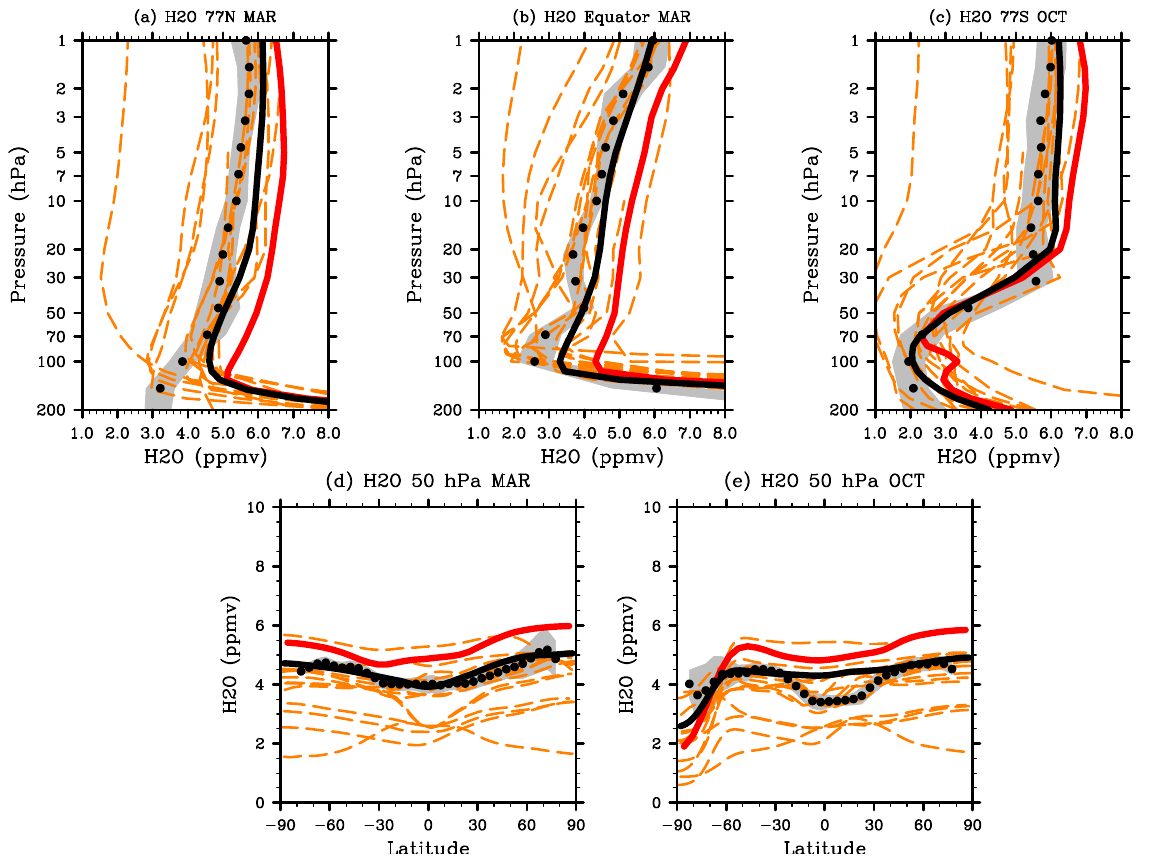
Fig. 7. Climatological (1992–2001) zonal-mean H 2 O mixing ratio (ppmv), for HALOE observations (black dots, with grey area showing ± 1 σ ), CNRM-ACM (red line), CNRM-CCM (black line), and CCMVal-2 REF-B1 models (dashed orange lines). Vertical profiles at (a) 77 ◦ N in March, (b) 0 ◦ N in March, and (c) 77 S in October. Zonal-means at 50 hPa in (d) March and (e) October.